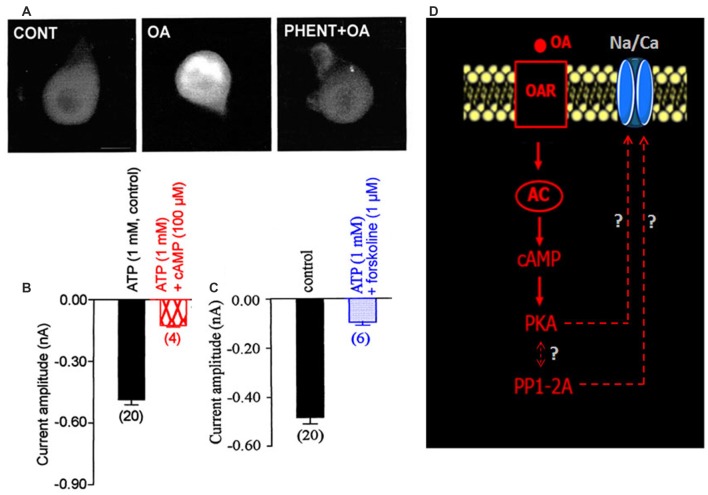
Involvement of adenylyl cyclase (AC) activity in the OA-induced modulation of the LVA maintained Na/Ca inward current. (A) Cyclic adenosine 3′,5′ monophosphate (cAMP) immunoreactivity of isolated DUM neuron cell bodies. Comparative change in immunofluorescence observed in control and after application of 1 μM OA. After pretreatment of DUM neuron cell body with 10 μM phentolamine, the OAR antagonist, cAMP immunostaining induced by OA was completely abolished (n = 8, in each experimental conditions). (B,C) Comparative histograms illustrating the mean current amplitude recorded at −40 mV from a holding potential of −100 mV under different experimental conditions indicated above each bar. Data are means ± SEM. Values in parentheses indicate number of experiments in each condition. (D) Hypothetic model indicating the participation of the increased cAMP concentration via AC activated by the action of OA on OAR, which modulates the LVA maintained Na/Ca inward current.